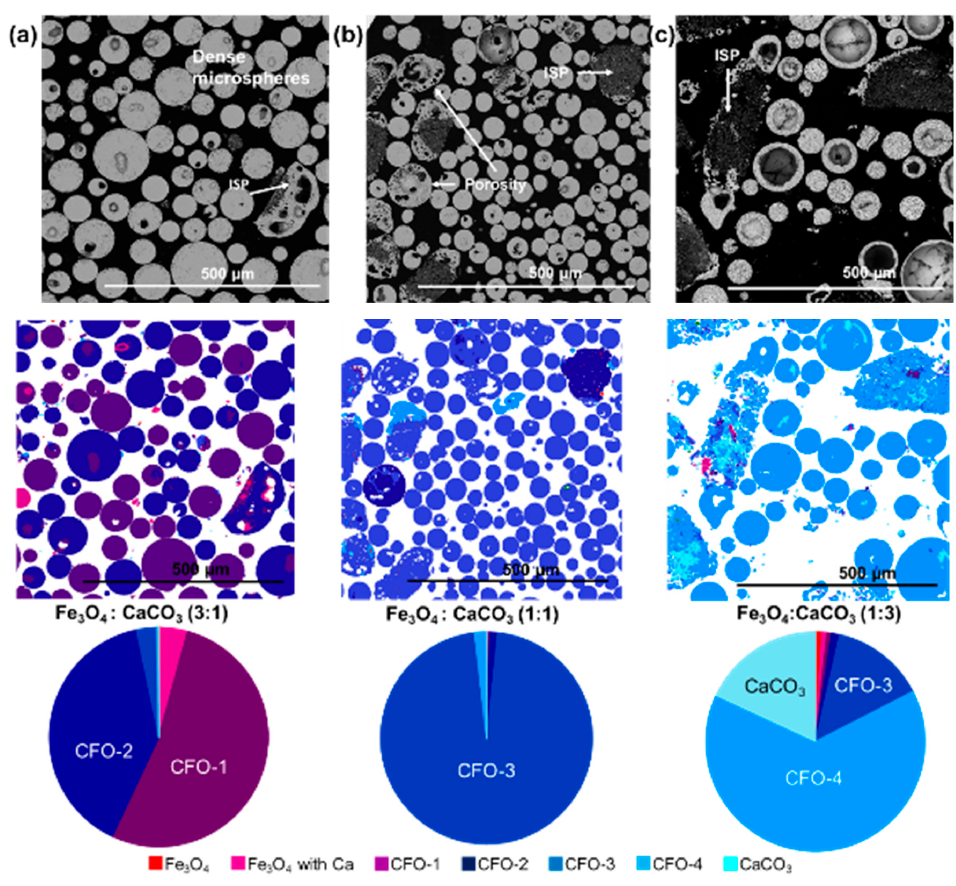
Figure 4. BSE images, MLA compositional analyses and associated pie-charts showing mineral proportions (wt%) of flame spheroidised Fe 3 O 4 :CaCO 3 as a function of mass ratio: ( a ) 3:1, ( b ) 1:1 and ( c ) 1:3; following sieving and sectioning, illustrating microsphere porosity, ISP, and dense microspheres. ISP: irregular-shaped particles; CFO: calcium iron oxide. Varying levels of internal porosity were observed for all sample sets. For the case of flame-spheroidised Fe 3 O 4 :CaCO 3 with mass ratio 1:1/gas flow setting 2.5:2.5 (Figure